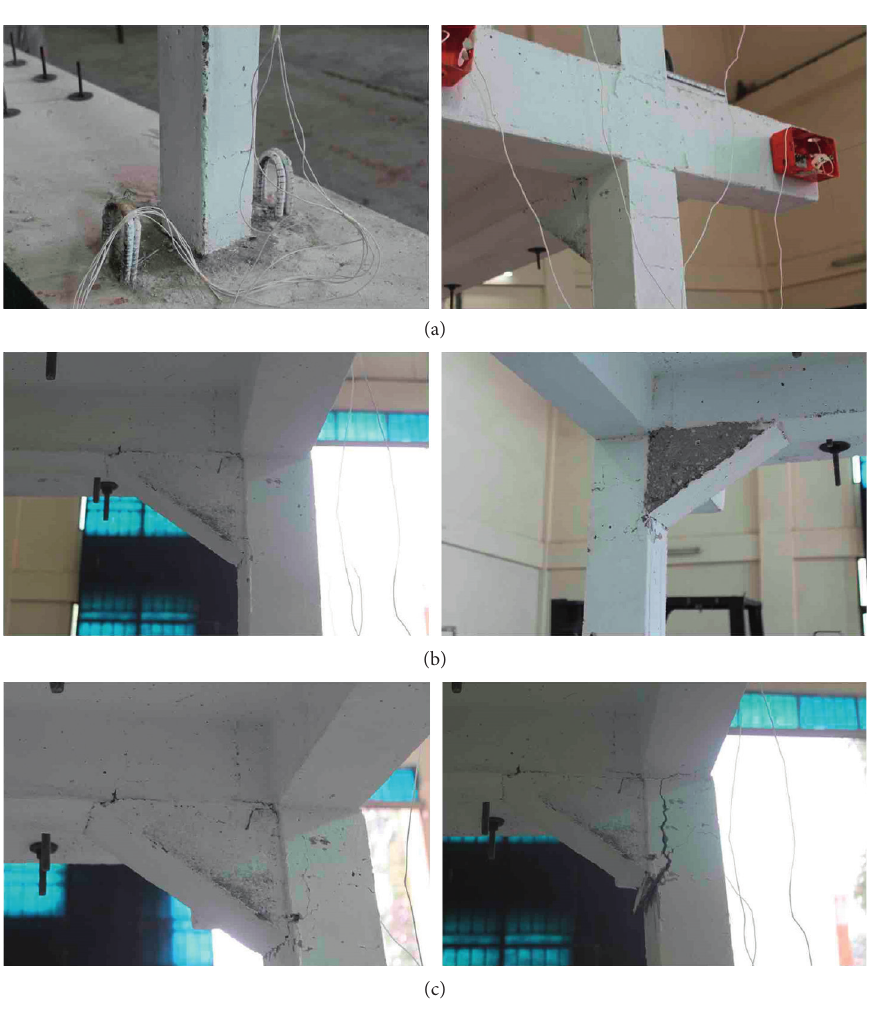
Figure 7: Observed damage in deficient models retrofitted with RC haunches, scheme-1. (a) Damage observed in columns during 30% run. (b) Damage observed in beam and columns during 40% run. (c) Damage observed in columns, respectively, under 50% and 70% run.